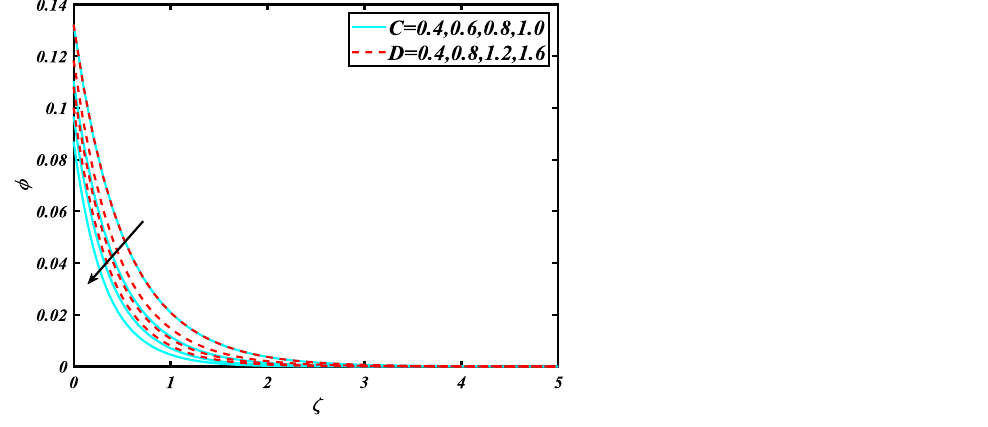
Figure 9. Significance of C & D for φ .